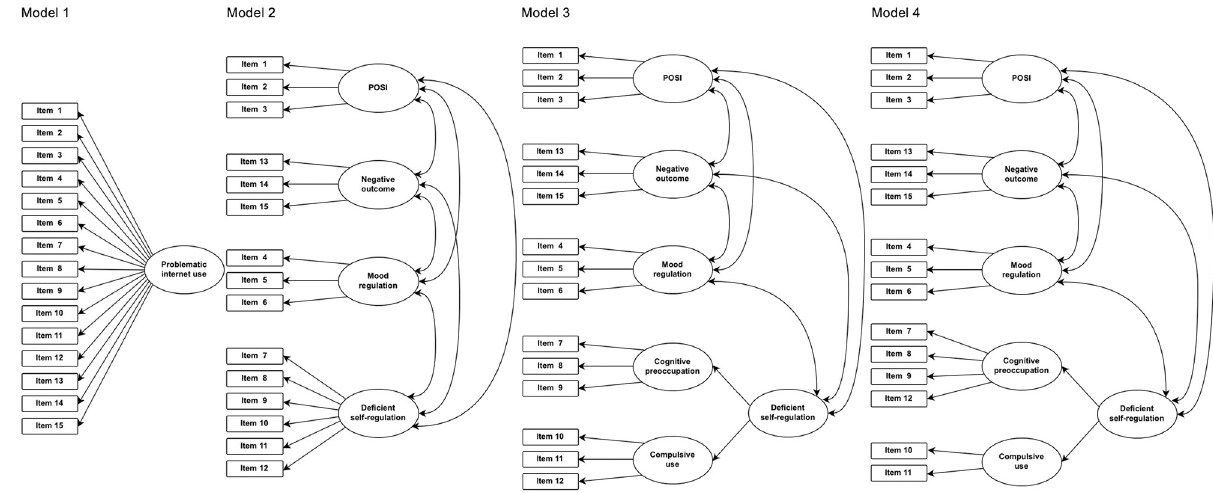
Fig 2. The four models evaluated using confirmatory factor analysis